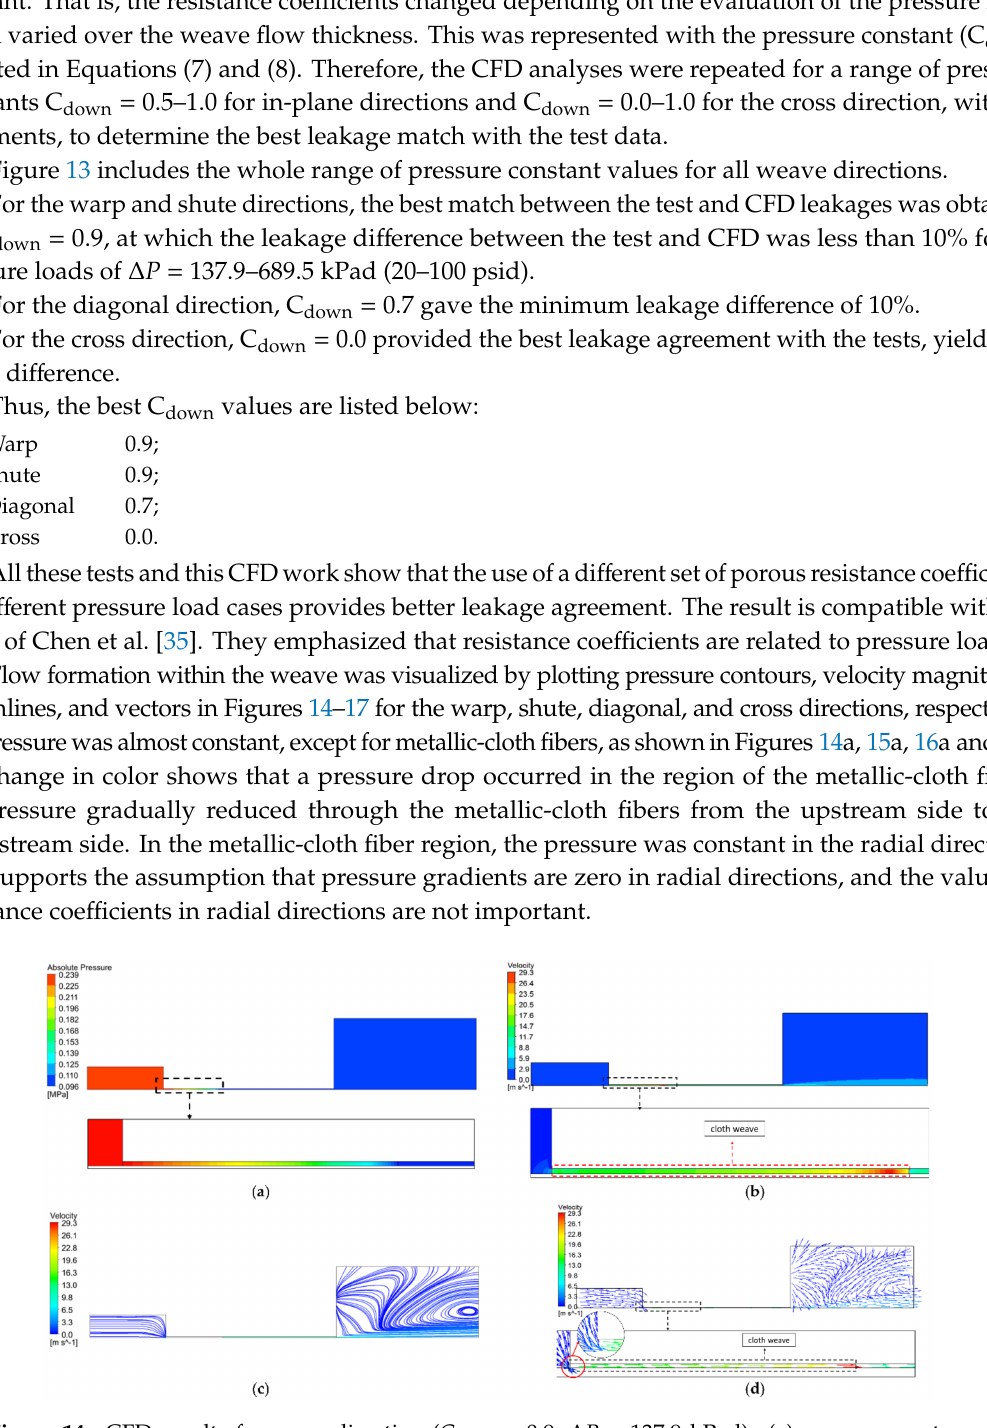
Figure 14. CFD results for warp direction ( C down = 0.9, ∆ P = 137.9 kPad): ( a ) pressure contours, ( b ) velocity magnitude contours, ( c ) velocity streamlines, and ( d ) velocity